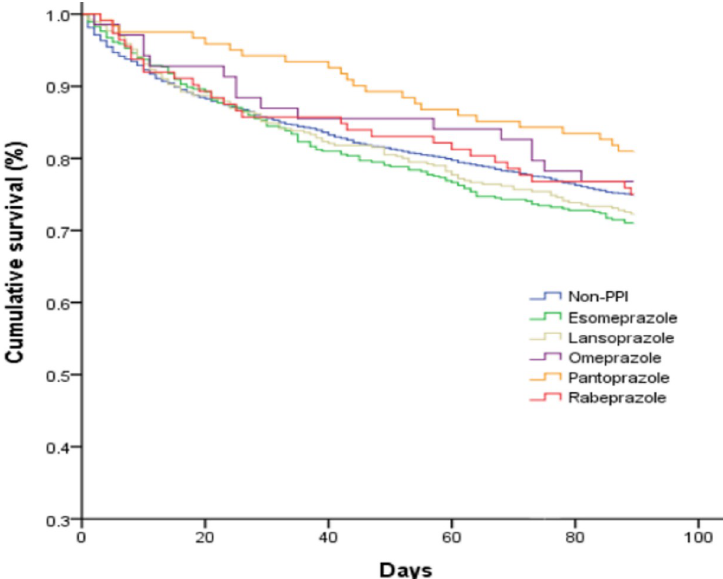
Fig 2. Cumulative survival plot for cirrhotic patients with pneumonia who were taking different oral proton pump inhibitors.